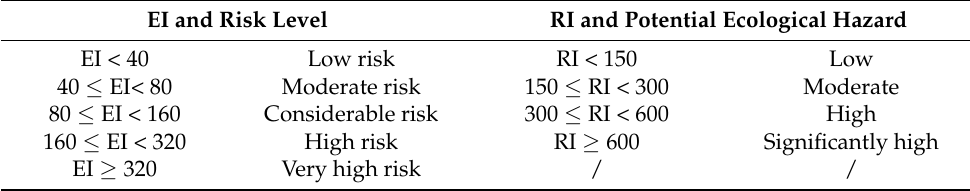
Table 2. Category of the potential ecological risk index EI and